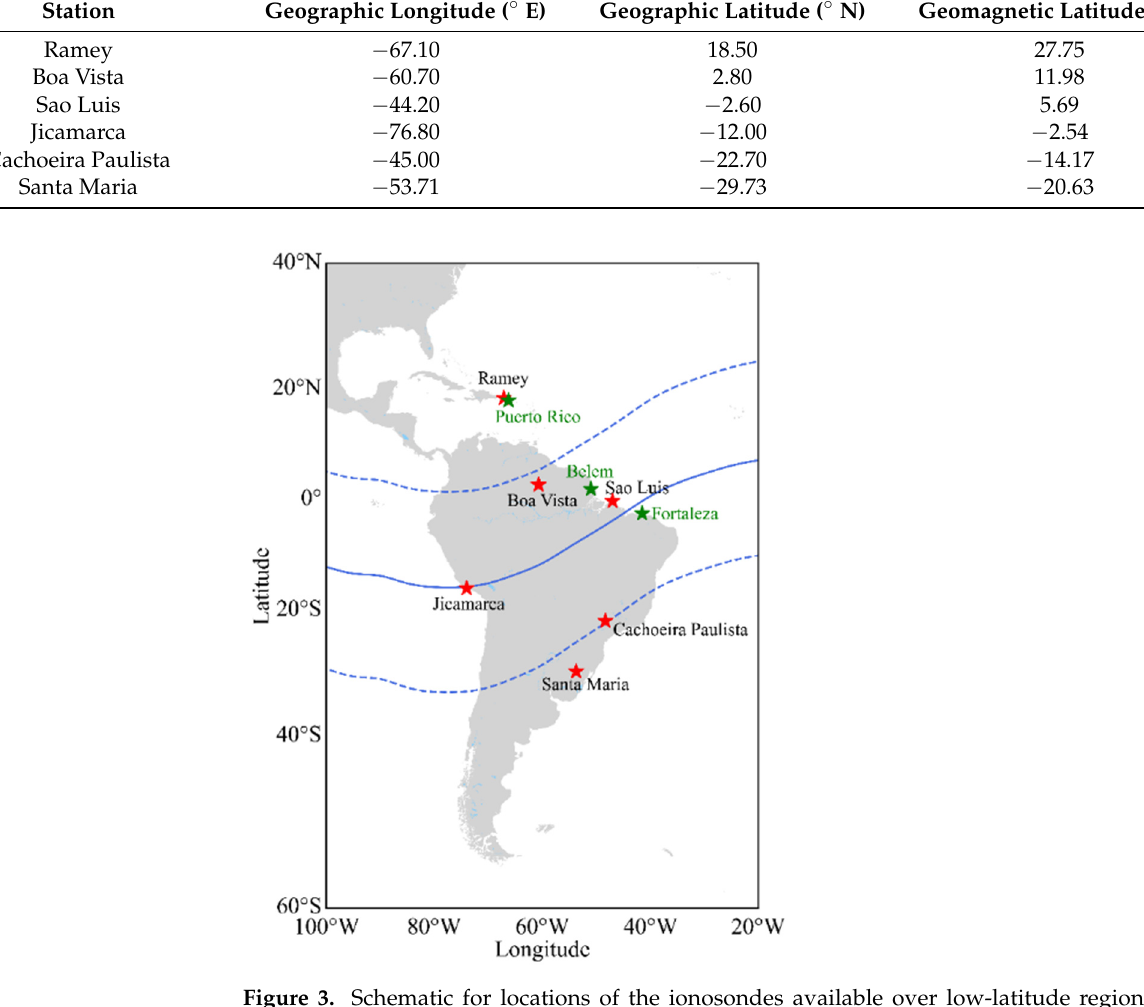
Figure 3. Schematic for locations of the ionosondes available over low-latitude regions of the Americas. Ionosondes marked with red pentagrams were used in this study. Lines show the magnetic equator and ±15° of the magnetic latitude.